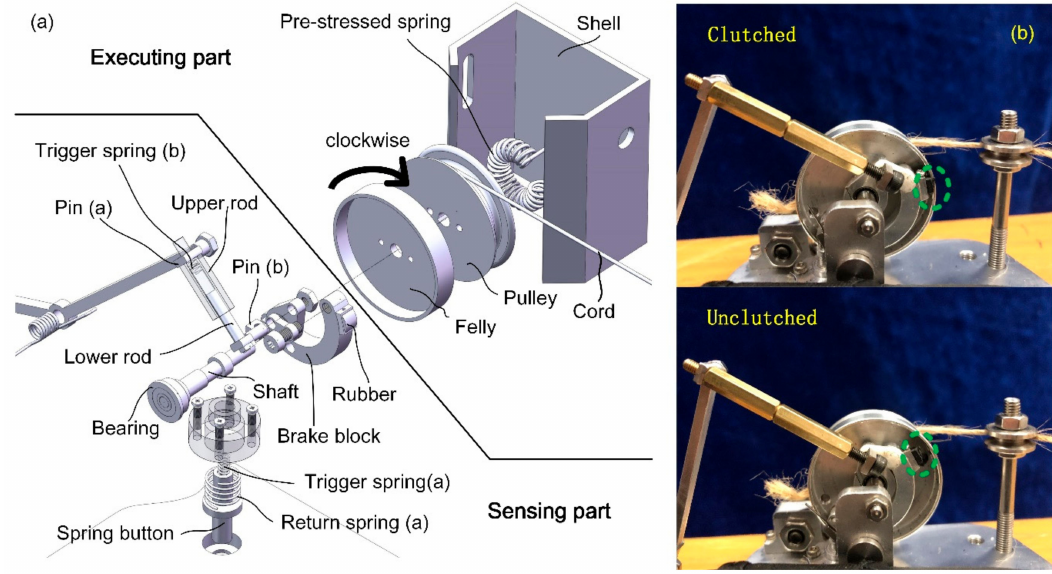
Figure 4. ( a ) The structure of the mechanical clutch. This sensor-controller integrated system consists of a sensing part and an executing part; ( b ) The clutched / unclutched state of the prototype, which relies on the contact state between the rubber and the wall of the felly